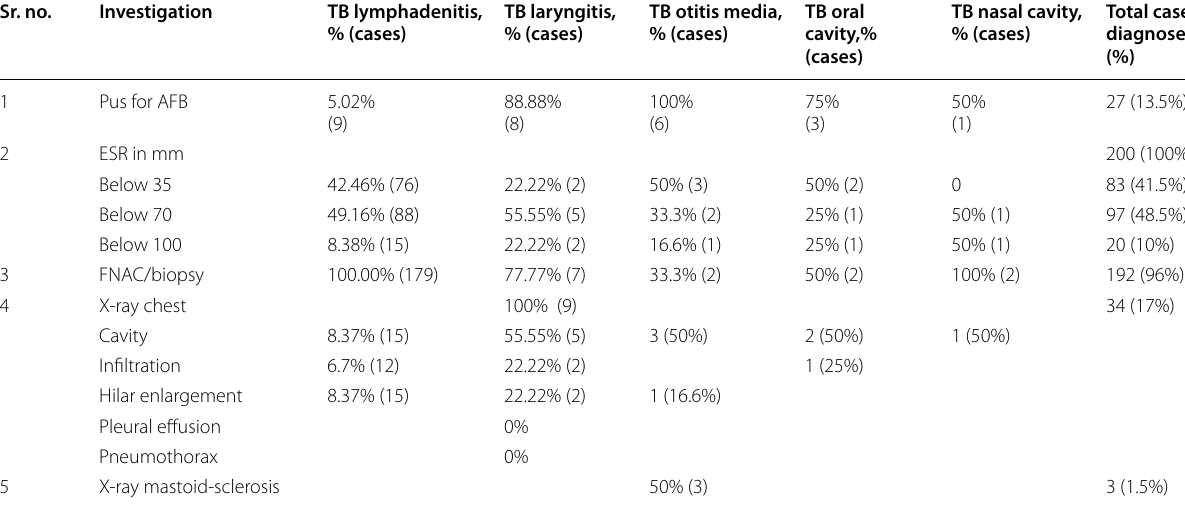
Table 4 Analysis of investigation in ENT and neck tuberculosis cases Sr. no.